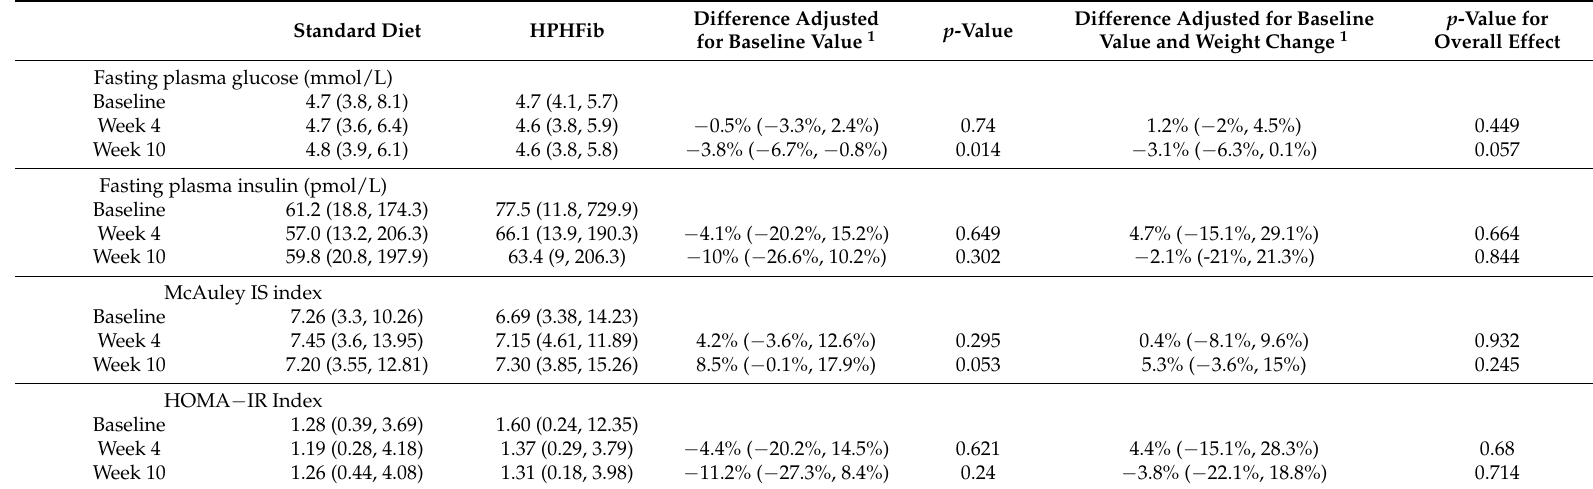
Table 5. Geometric mean (min, max) measures of insulin sensitivity, based on fasting blood samples at baseline, week 4 and week 10 and percentage differences between dietary groups, adjusted for baseline values and weight